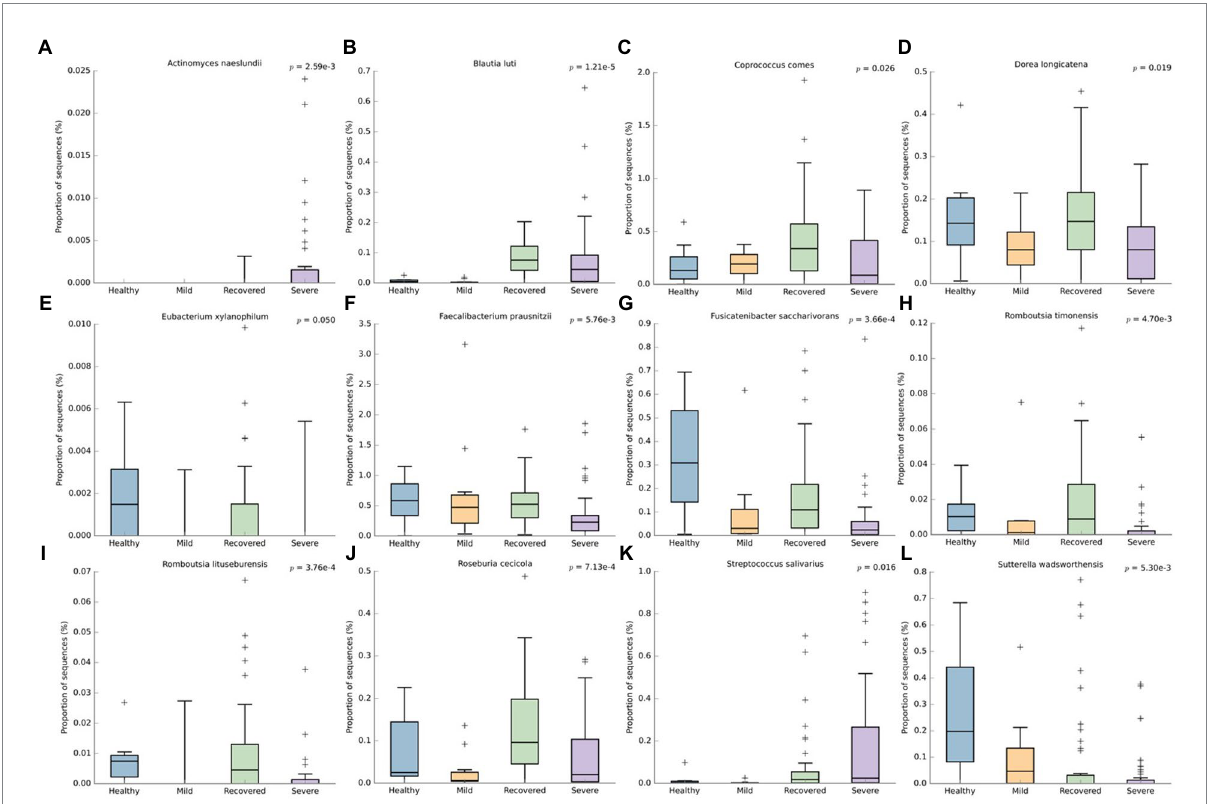
FIGURE 5 Boxplots representing the relative abundance of significant bacterial species: (A) Actinomyces naeslundii , (B) Blautia luti , (C) Coprococcus comes , (D) Dorea longicatena , (E) Eubacterium xylanophilum , (F) Faecabacterium prausnitzii , (G) Fusicatenibacter saccharivorans , (H) Romboutsia timonensis , (I) Romboutsia lituseburensis , (J) Roseburia cecicola , (K) Streptococcus salivarius , (L) Sutterella wadsworthensis . This analysis was performed with We’ch’s t-test and an effect size filter of 0.05, to compare the abundance differences between the